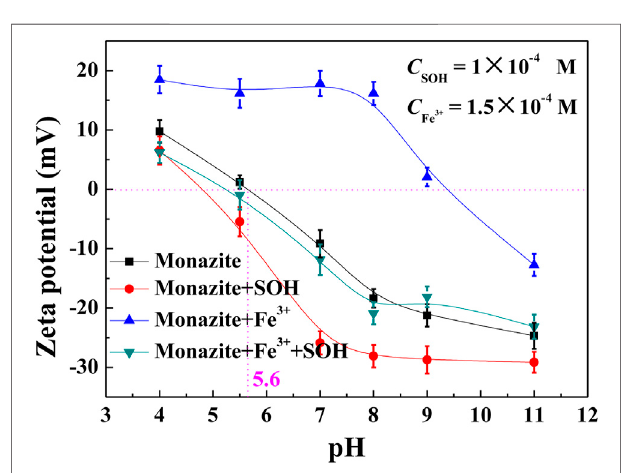
FIGURE6| Zetapotentialofmonaziteunderdifferentreagentconditions as a function of pH.